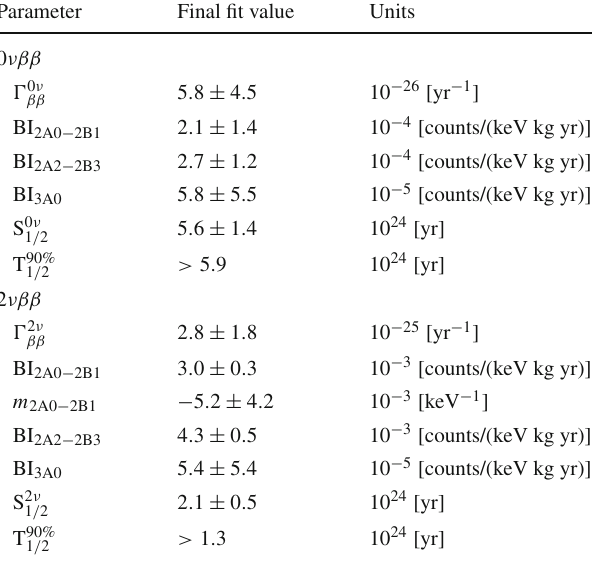
Table 5 We report here mean and standard deviation of the marginal- ized posterior distributions for the decay rate and background parame- tersforeachsignature,derivedfromunblindeddata.TheS 1 / 2 parameter indicates the median expected sensitivity for limit setting at 90% C.I. on the T 1 / 2 parameter together with the MAD of its distribution. The last row reports the marginalized 90% C.I. Bayesian lower limit on the decay half life. All results come from the combined fit with